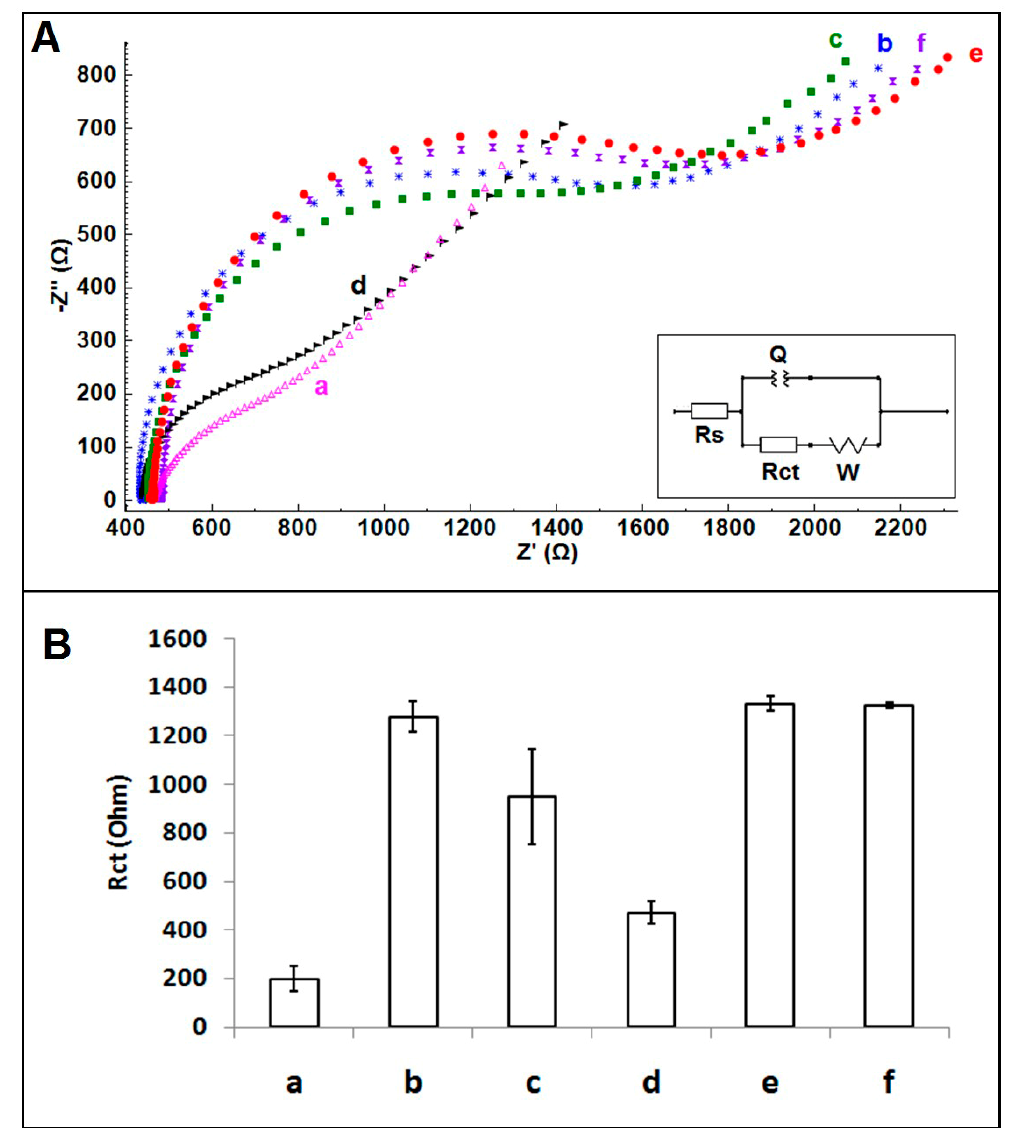
Figure 5. ( A ) Nyquist diagrams, ( B ) Histograms representing pseudo hybridization of (a) 1 µg/mL ZNA probe, after hybridization of 1 µg/mL ZNA probe with 10 µg/mL (b) mDNA target, (c) wDNA target, after pseudo hybridization of (d) 1 µg/mL DNA probe, after hybridization of 1 µg/mL DNA probe with 10 µg/mL (e) mDNA target, (f) wDNA target.